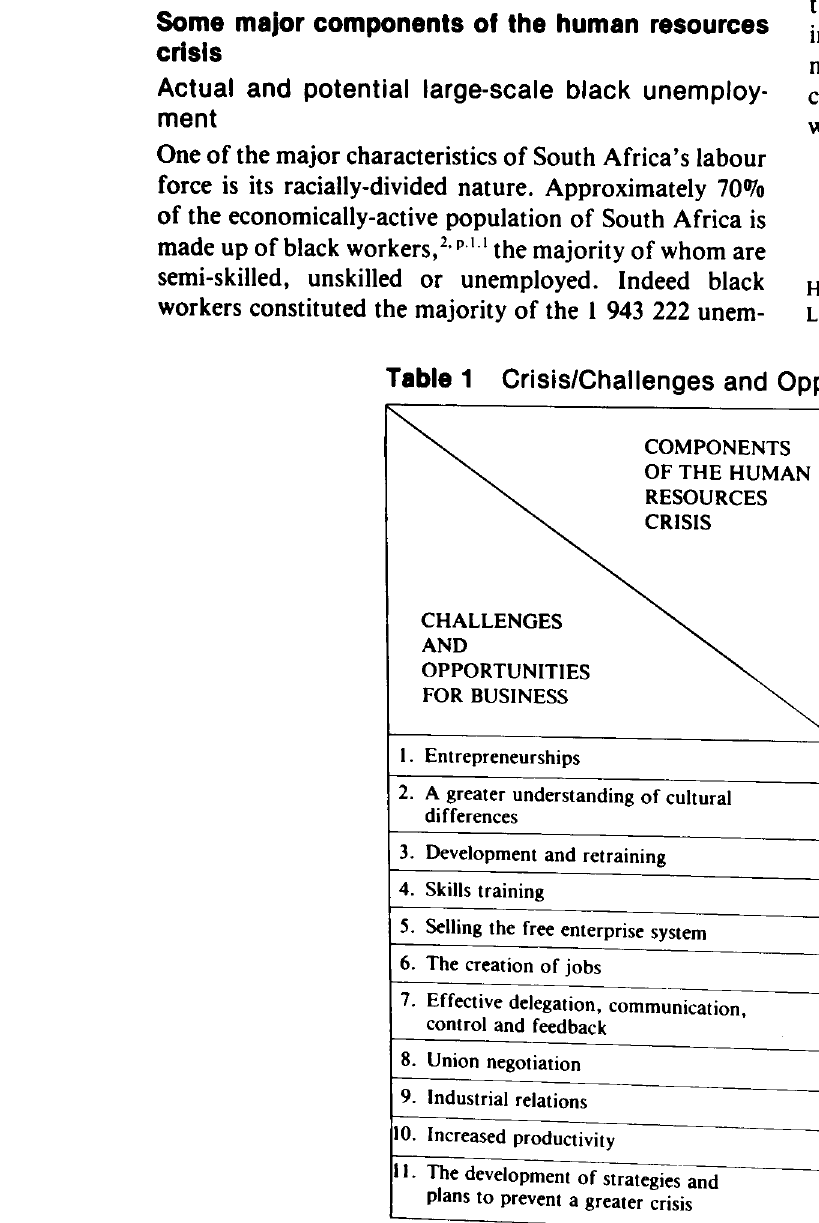
Crisis/Challenges and Opportunities Matrix